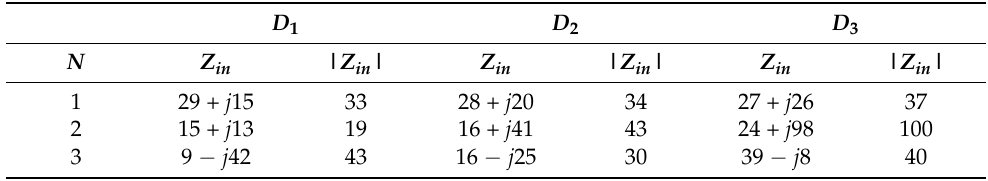
Table 1. Input impedance values of the sensor in ohms for three N modes and three D configurations at resonant frequencies.